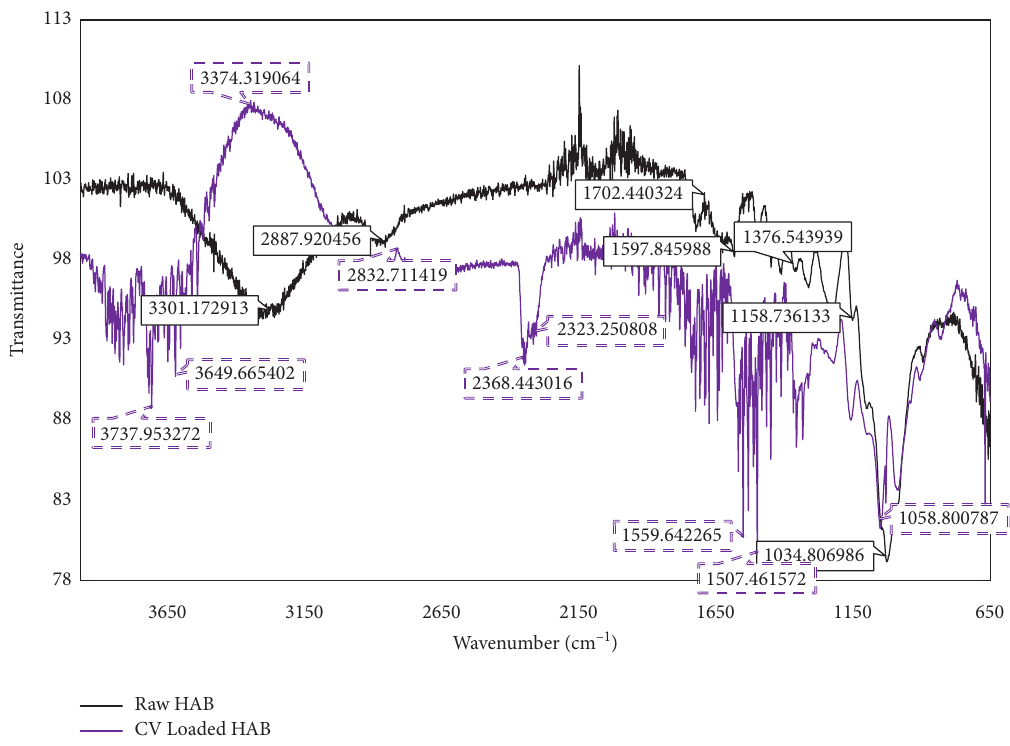
Figure 1: FTIR spectra of raw HAB and GV loaded HAB. Table 1: Physiochemical characterization of Heterophragma adenophyllum